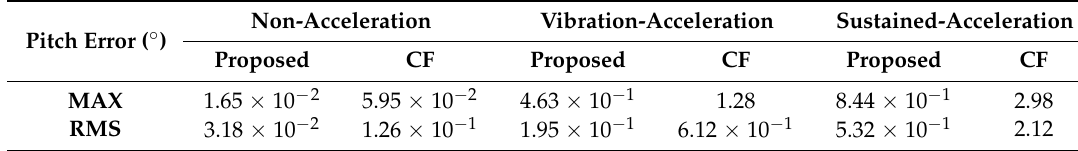
Table 2. Max and RMS pitch error in three acceleration modes.